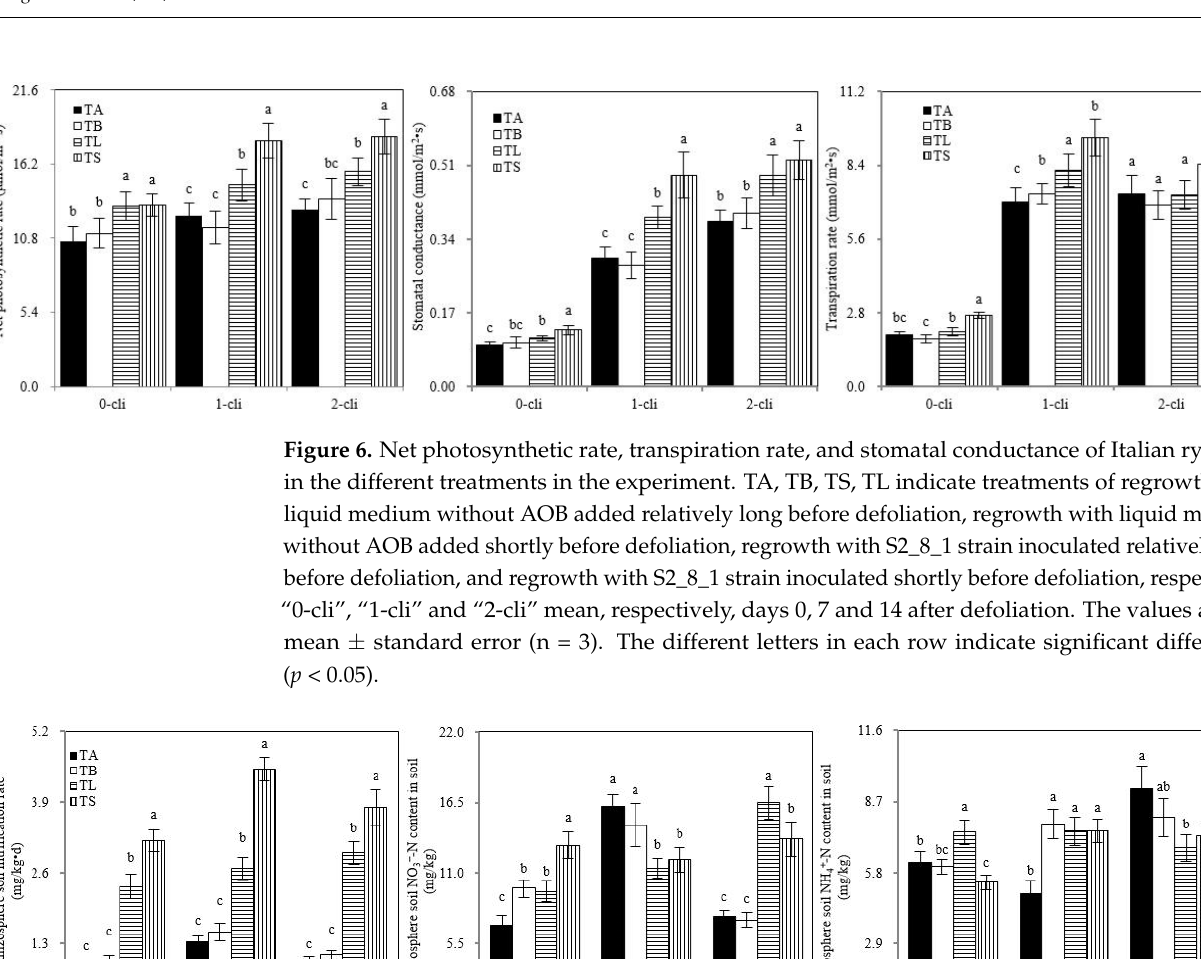
Figure 8. Zeatin riboside concentrations in the newly grown leaves, R ZR and C ZR in the xylem saps in different treatments in the experiment. TA, TB, TS, TL indicate treatments of regrowth with liquid